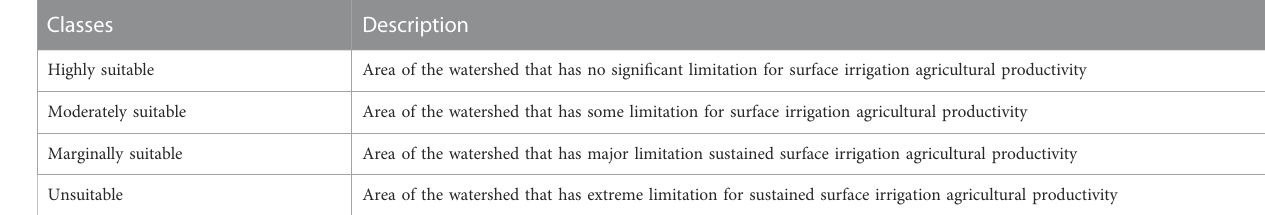
TABLE 1 Surface irrigation potential classi fi cation. Classes